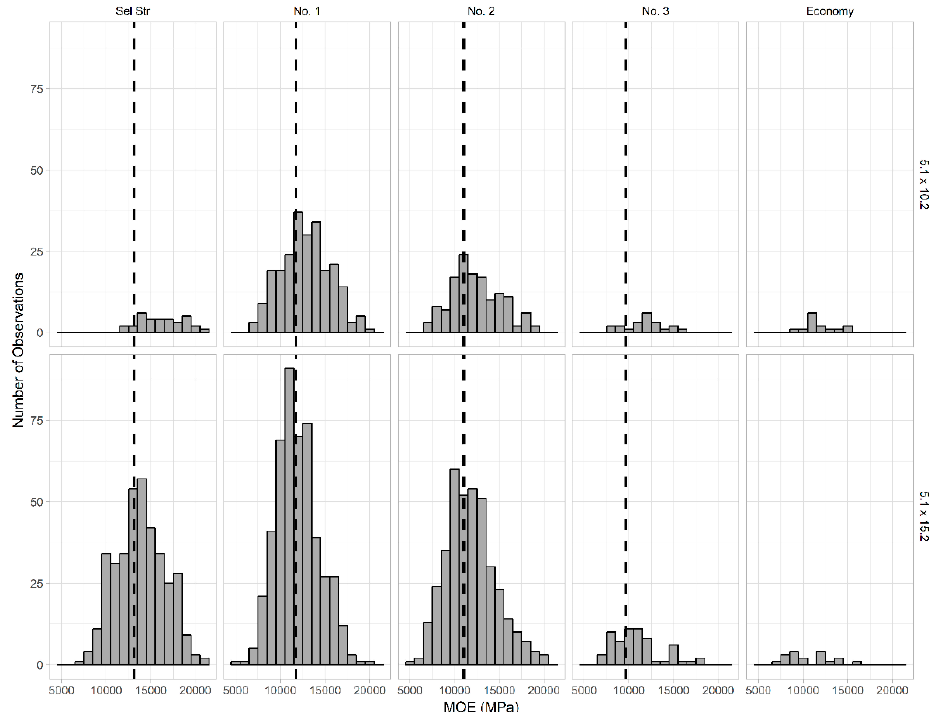
Figure 4. Distribution of lumber MOE by lumber size and visual grades. The dotted vertical line is the published MOE value for the specific grade. Economy lumber does not have a structural design value assigned to it.